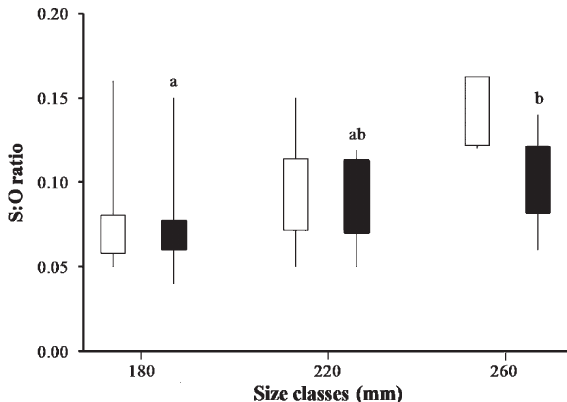
Fig. 7. – Box plots (maximum, minimum, upper and lower quar- tiles) for the sulcus area:otolith area ratio ( S:O ) by size class (CL) in A. carbo (white boxes) and A. intermedius (black boxes). Means with different superscript are significantly different ( P